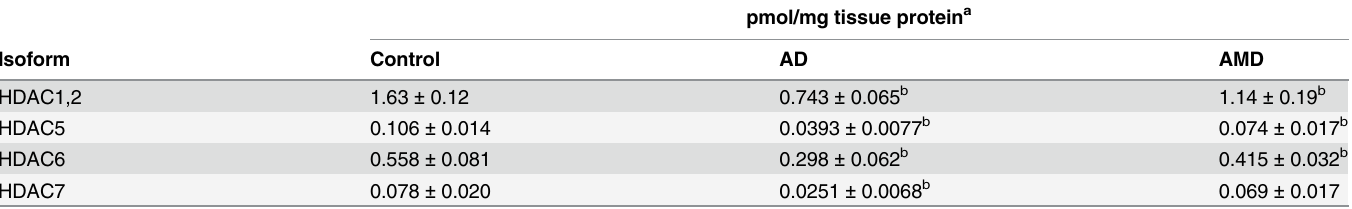
Table 2. HDAC concentrations in human neural